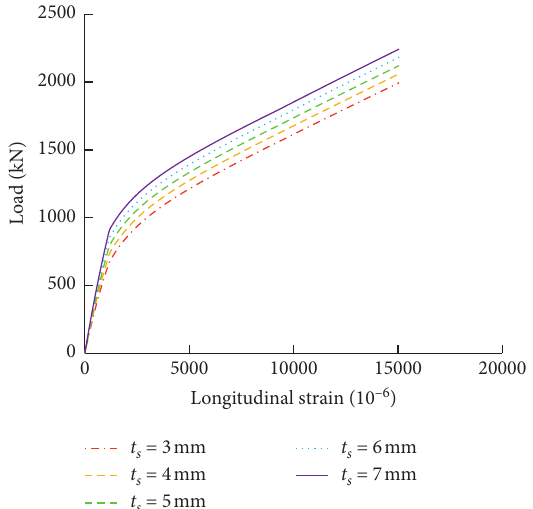
Figure 11: Effect of thickness of steel tubes.